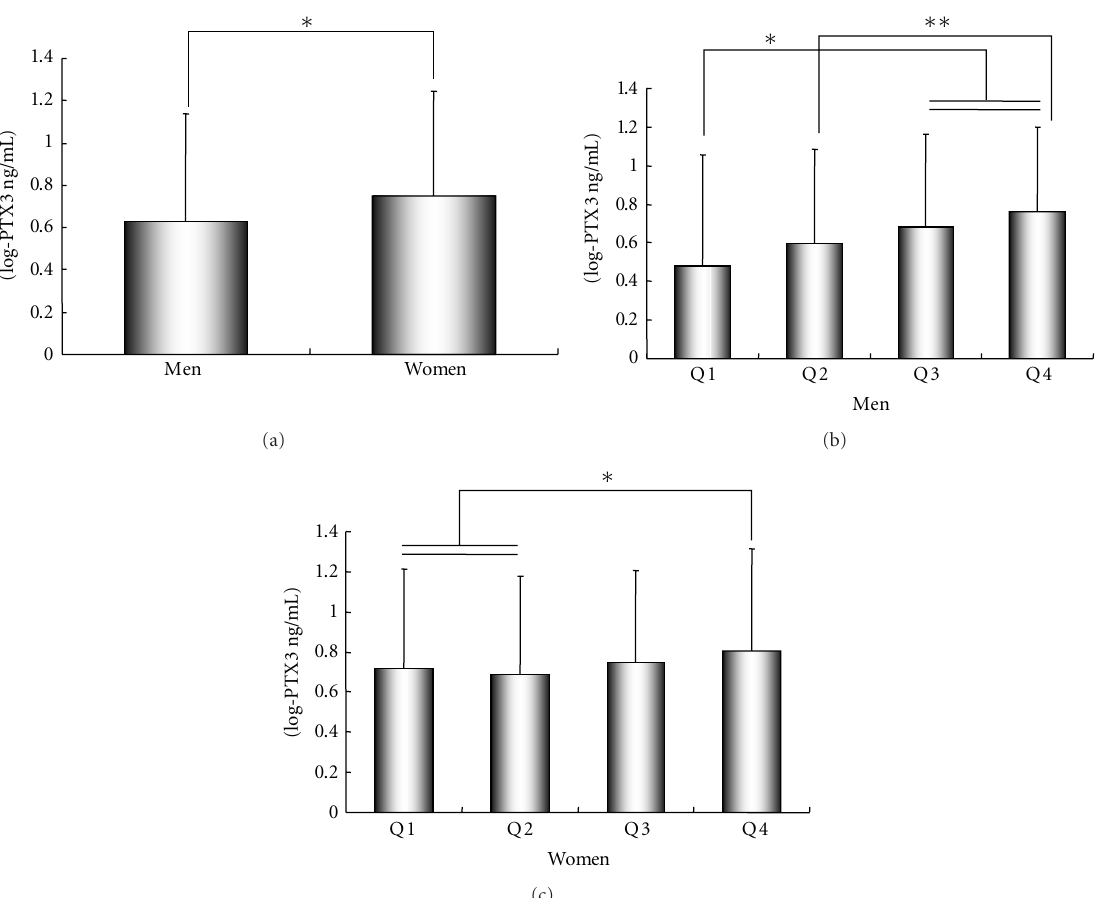
Figure 1: Geometric mean PTX3 plasma levels in men and women [25]. (a) Mean and confidence interval of natural log transformed PTX3 in men and women. Plasma PTX3 levels in men are significant lower than those in women (men, 1.87 (1.81, 1.94)ng/mL; women, 2.12 (2.05, 2.19)ng/mL). ∗ P < 0 . 0001. (b) Plasma PTX3 levels according to quartiles of age in men. Quartile 1 (Q1): 37–49 years old; 1.62